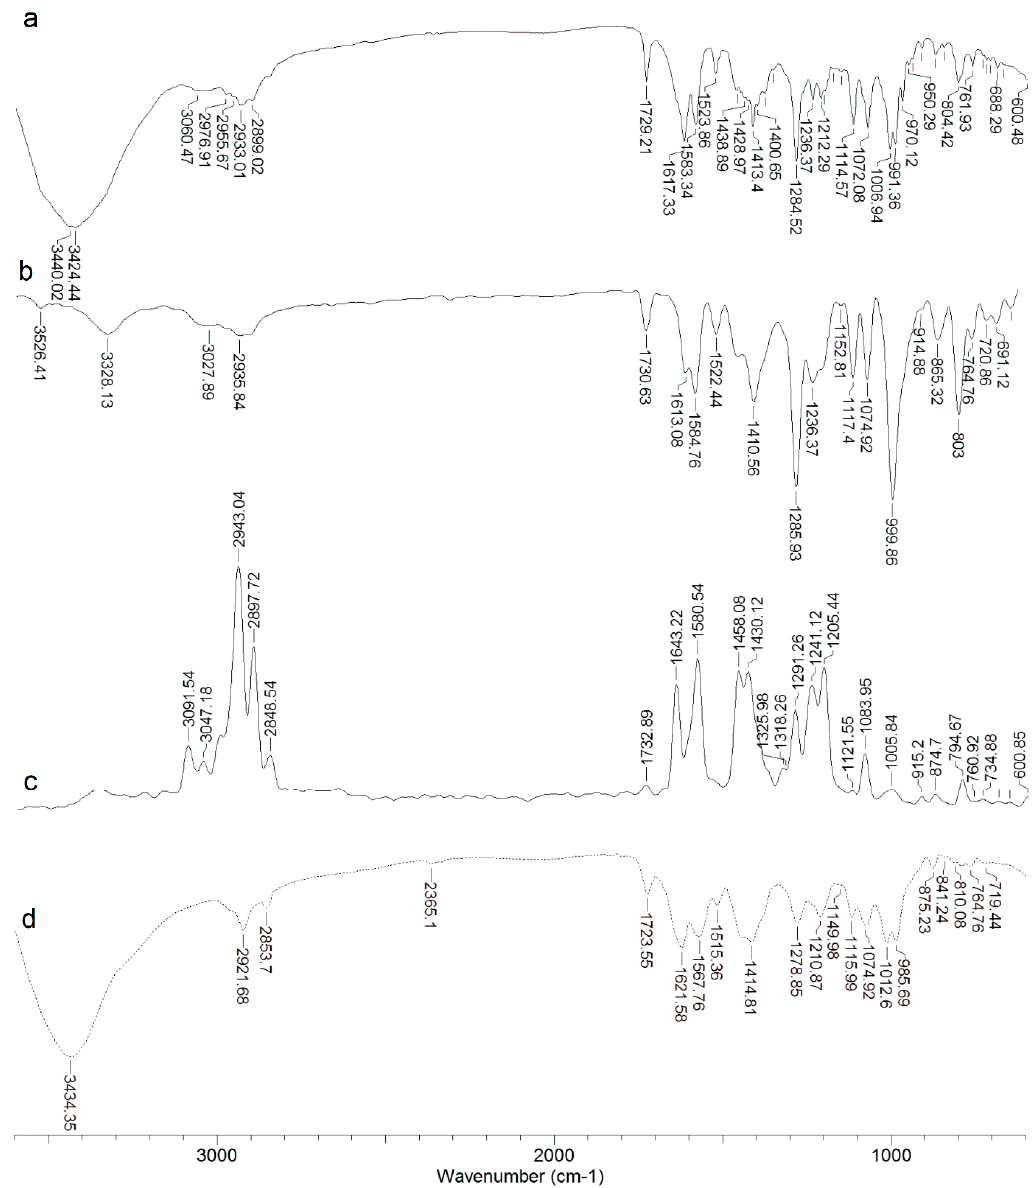
Figure 2. IR KBr ( a ) and ATR ( b ) and Raman ( c ) spectra of DOX (continuous lines) and IR KBr spectra of Cu-DOX complex (the dotted line) ( d ).